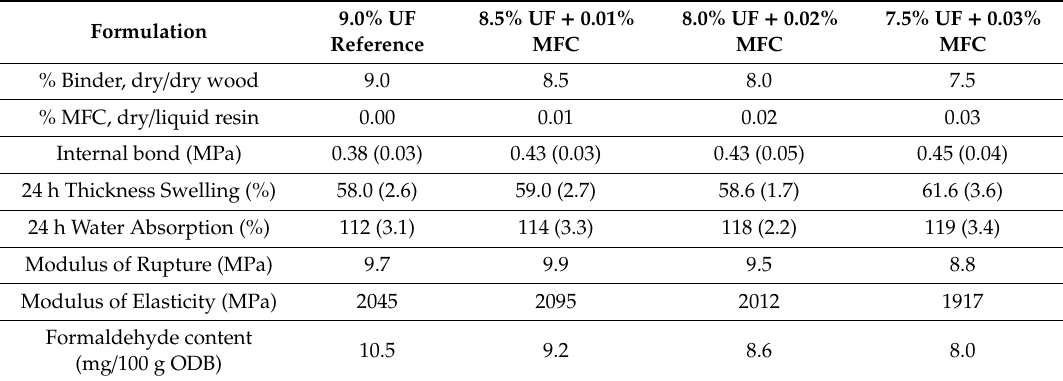
Table 6. Particleboard panels analysis, MFC 2% increasing levels, resin decreasing, Approach